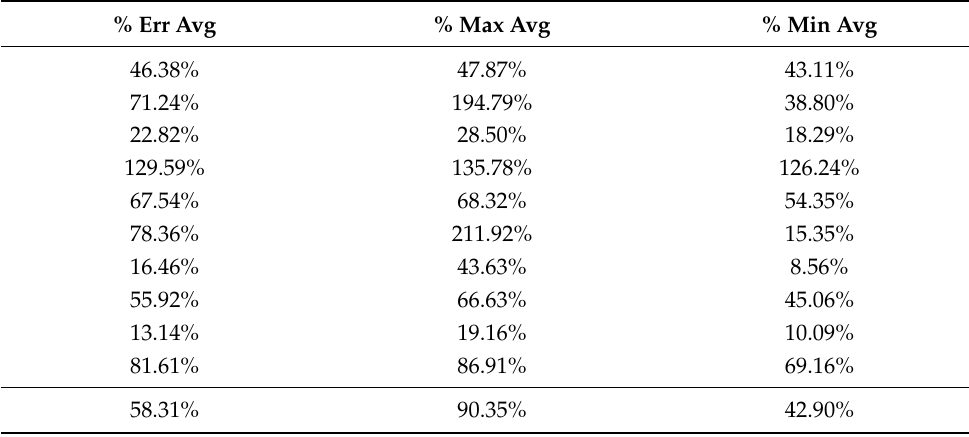
Table A74. Set 1, trials 41–50 data (average actual PR